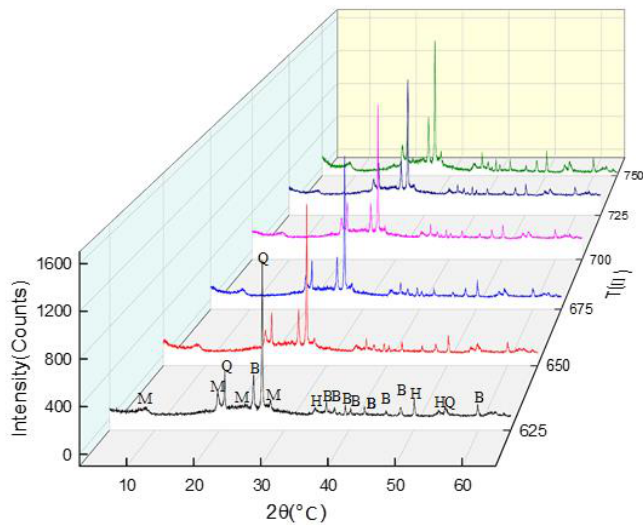
Figure 5. XRD spectra of the calcined powders at different temperatures. H: hematite, Fe 2 O 3 .